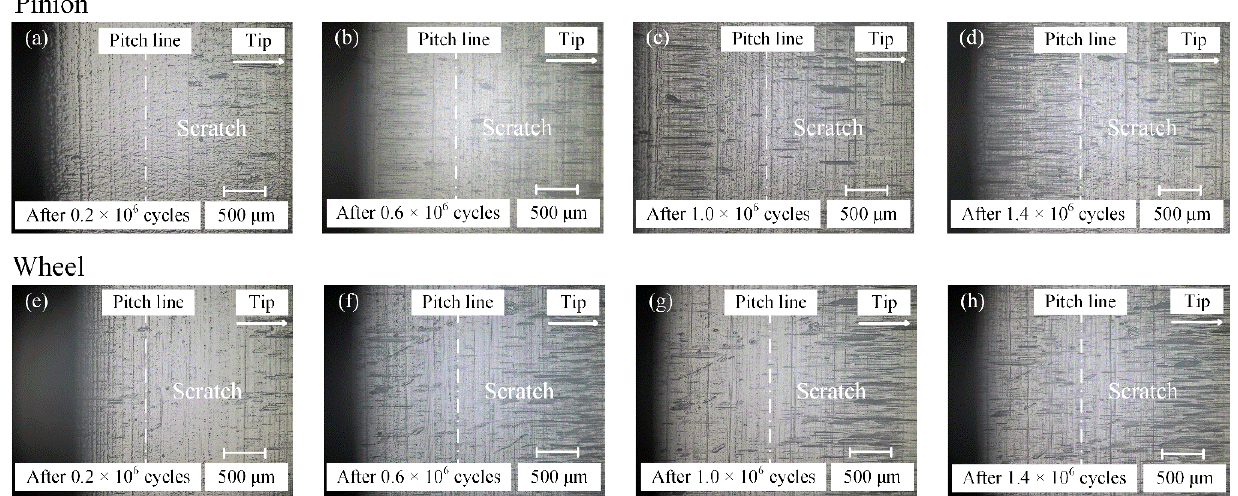
Fig. 18 Wear evolution for the lubricated 20 N·m loading case.